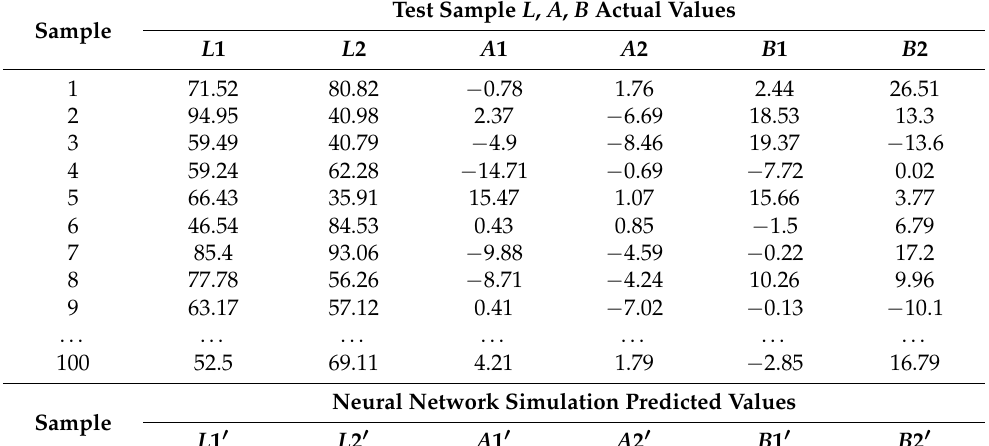
Table 4. Simulation results of the semantic mapping model of ceramic two-color matching perceptual based on BP neural